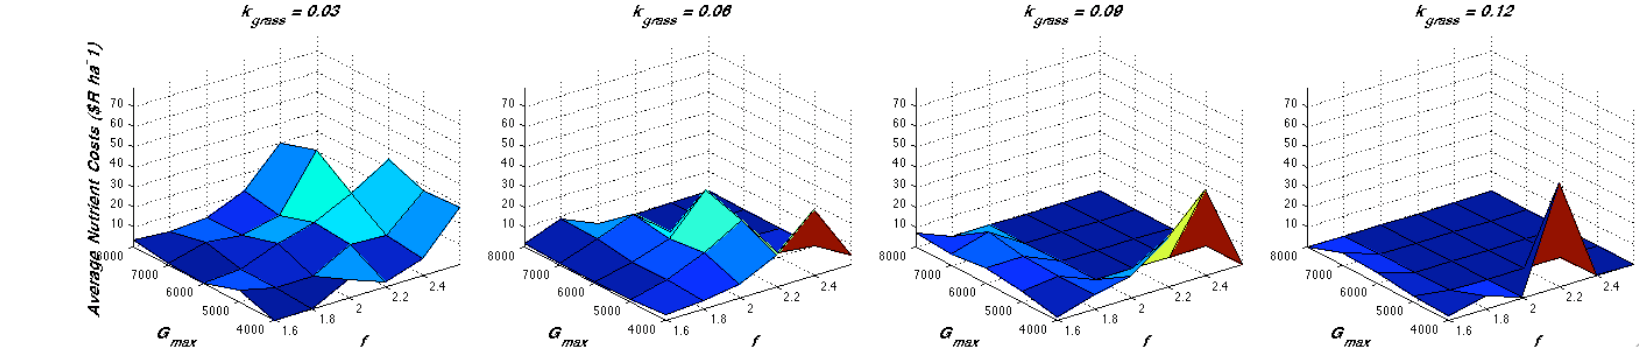
Figure A2.4: Average nutrient costs ($R/ha/y) across dimensions of grass capacity G growth rate k (/t). Individual surfaces show average nutrient costs as a function of grass capacity and stocking factor f at a constant intrinsic grass grass growth rate.